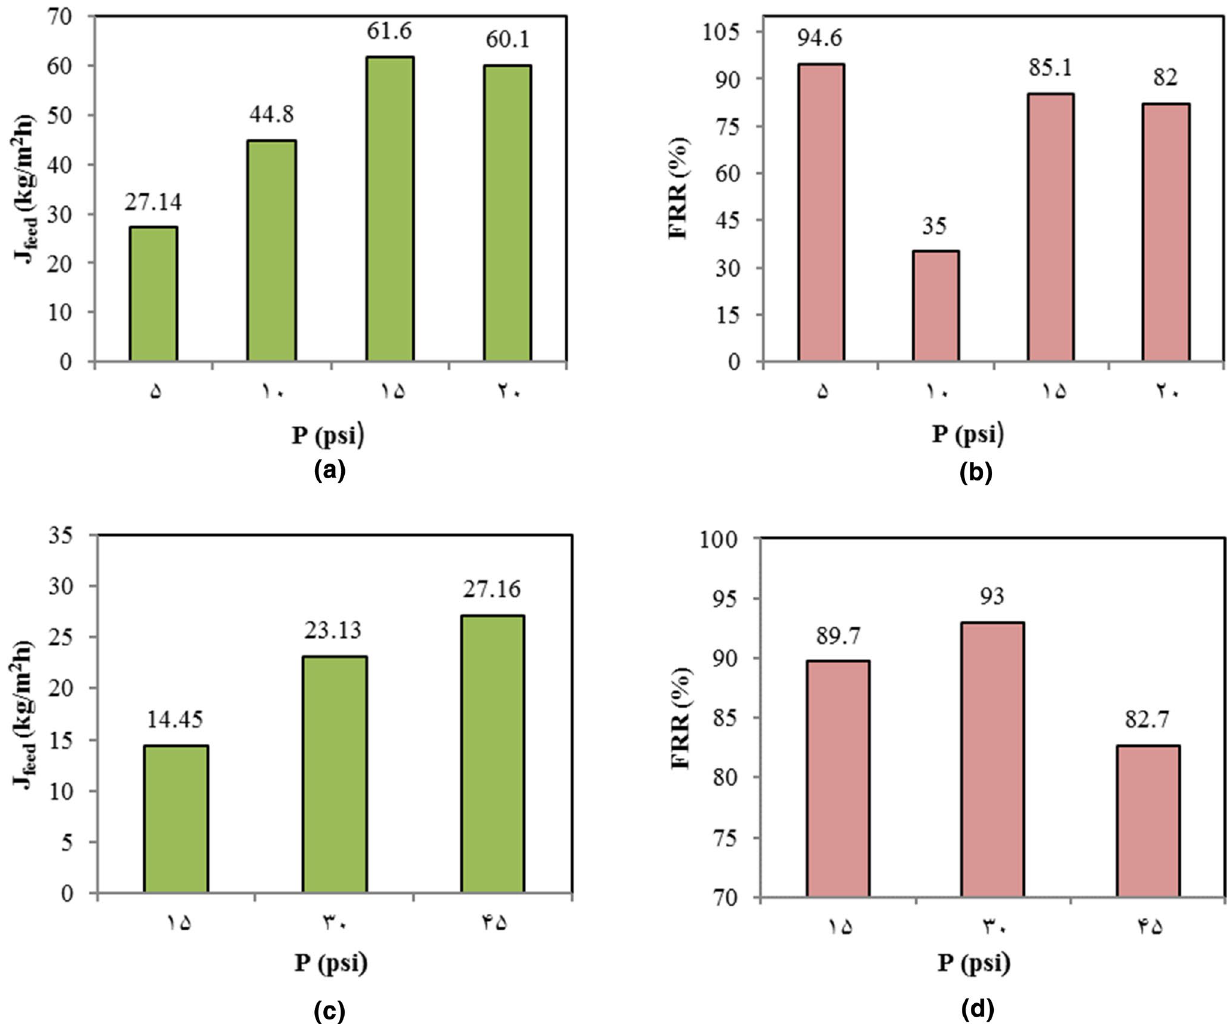
Fig. 5 J Feed ( a ) and FRR ( b ) measured for MF membrane and drink wastewater (HRT = 4